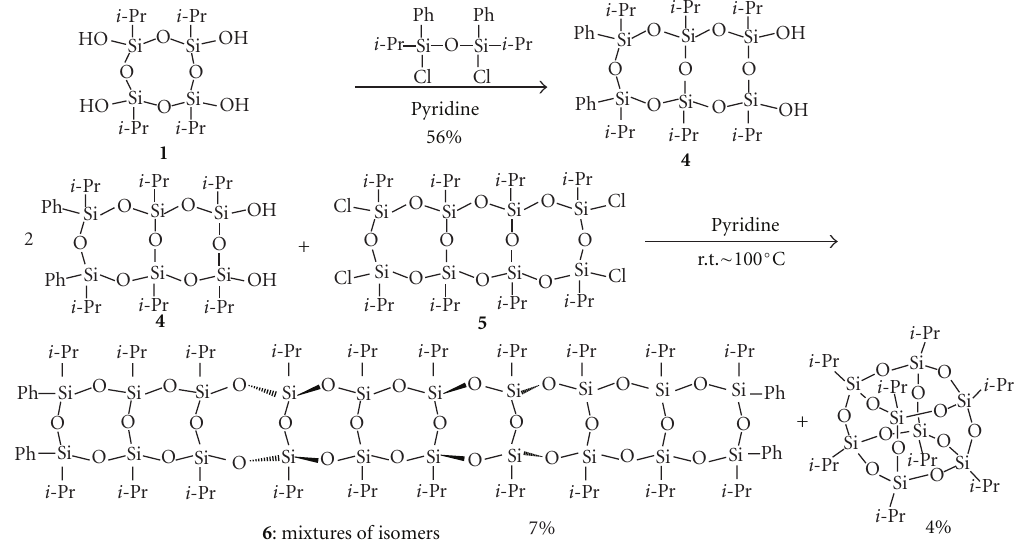
Scheme 3: Synthesis of nonacyclic ladder silsesquioxanes.